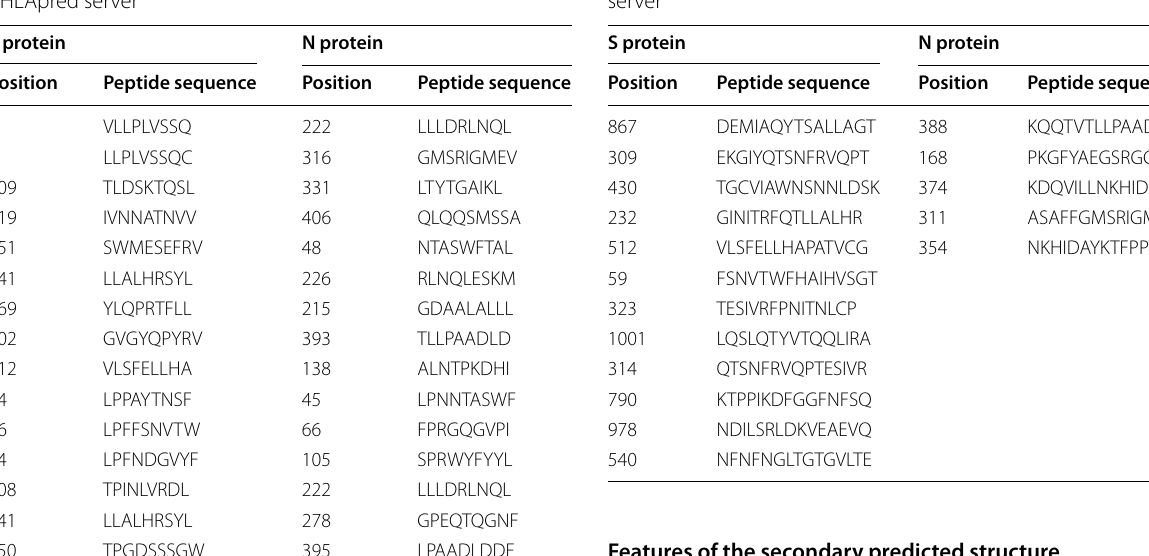
Table 2 Results of CTL S and N protein epitope prediction by Table 3 HTL epitope prediction results by NetMHCIIpan